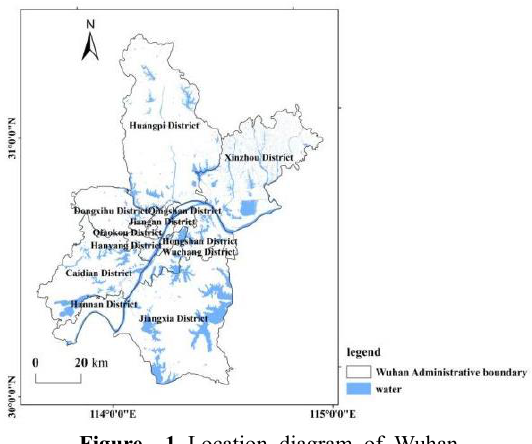
Figure . 1 Location diagram of